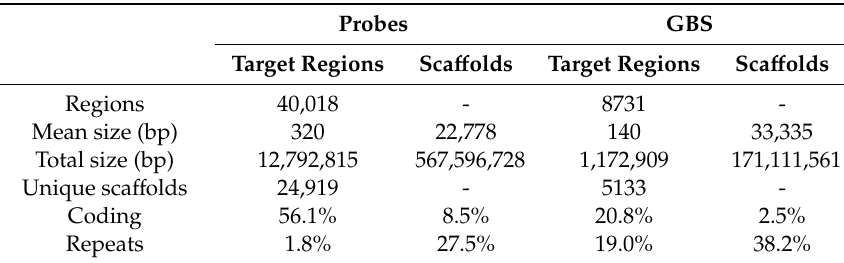
Table 2. Summary of probe and GBS